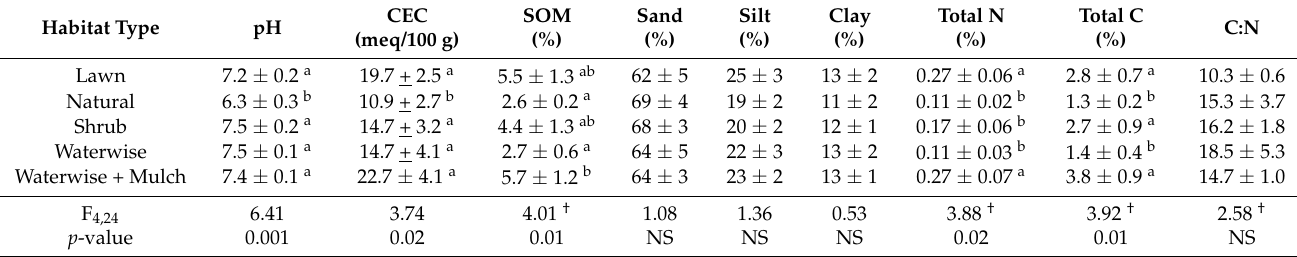
Table 2. Mean ( ± se; n = 7 campuses) soil physical and chemical properties for each landcover type. Shown also are the results of a randomized-block ANOVA (F-statistic, degrees of freedom, and p -value) with campus as the blocking (random variable) and landcover type as a fixed effect. In the case of a significant ANOVA, means with a different lower-case letter are significantly ( p < 0.05) different from each other according to a Tukey–Kramer post hoc test. CEC = cation exchange capacity; SOM = soil organic